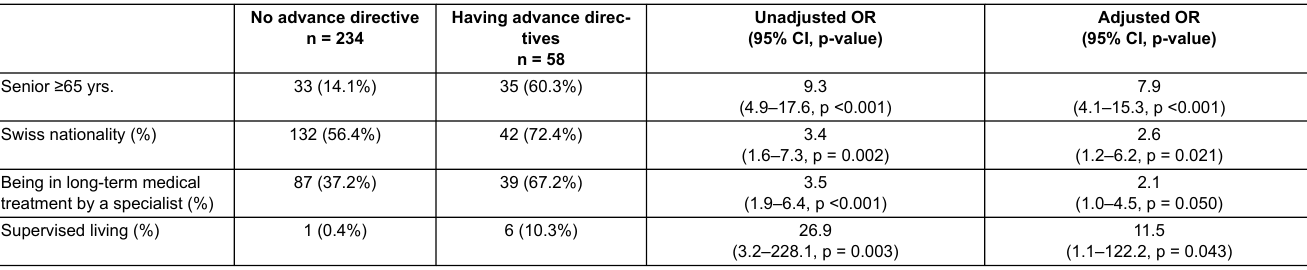
Table 4: Factors associated with an increased likelihood for having an advance